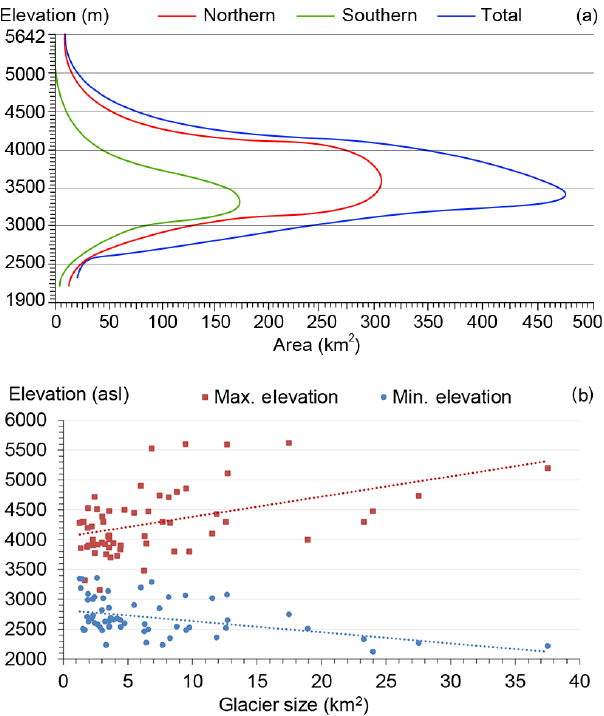
Figure 7. (a) Distribution of glacier area with elevation for northern, southern and both slopes in the Greater Caucasus. (b) Scatter plot showing glacier size vs. minimum and maximum